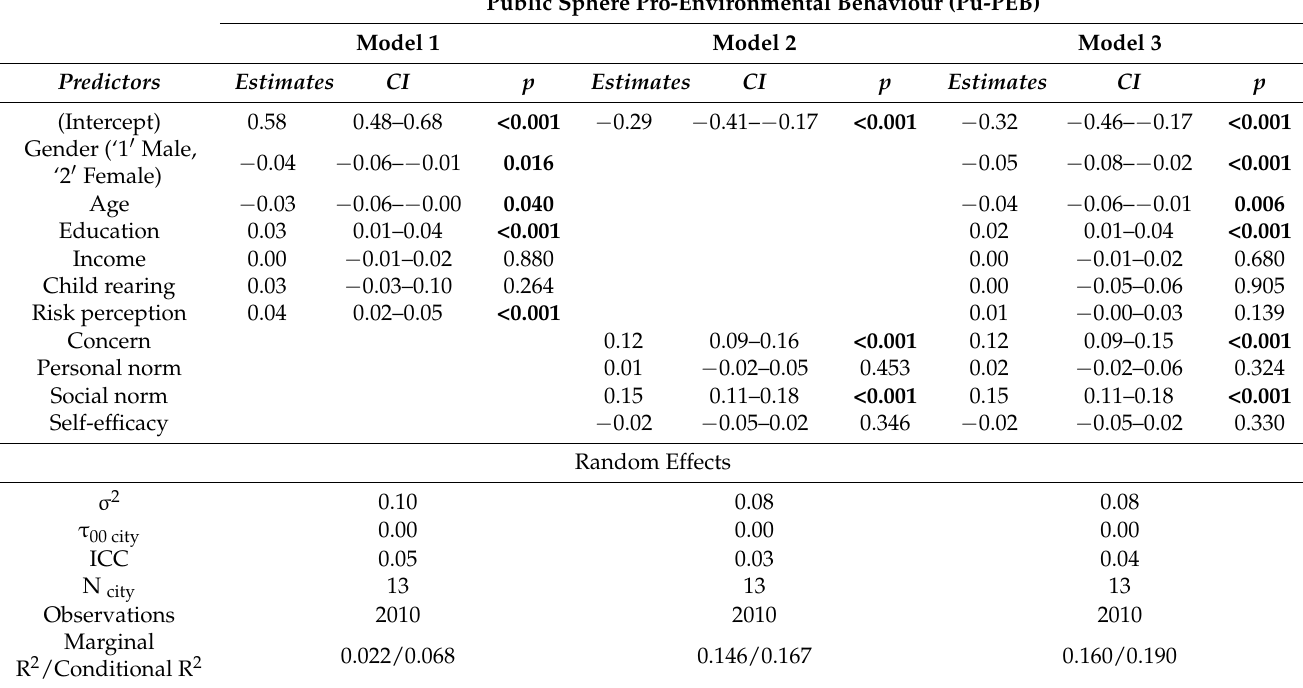
Table 2. Predicting changes in public sphere pro-environmental behaviour to air pollution by demographic variables and social–psychological variables.